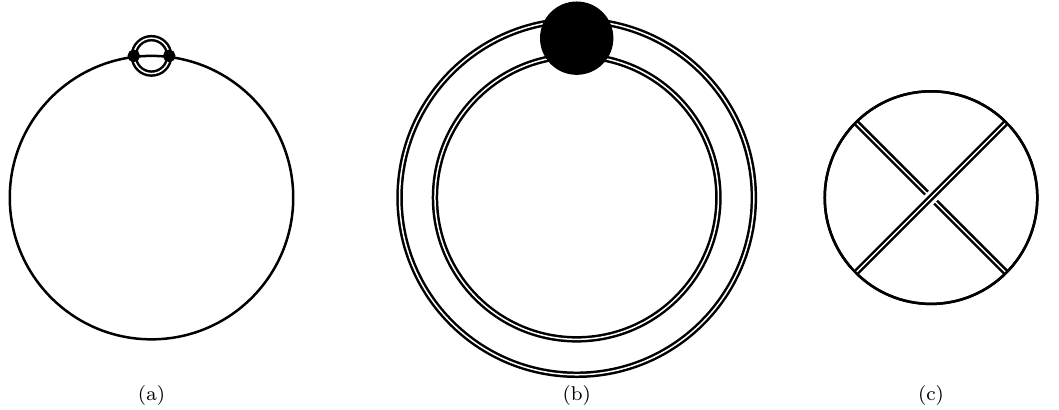
Figure 21 . (a) The big circle is a cartoon representing the locus M dual to w 1 . A (cid:5) line is bubbled nearby and dipped into this locus. The operators at the two marked junctions are inverses of each other. (b) Taking the left half of (cid:5) line around a loop C in M which intersects once the locus L 0 dual to w 2 , brings us to the con(cid:12)guration shown in the (cid:12)gure. We omit M in this (cid:12)gure for brevity. 1 The region denoted by a black disk is shown in (c). That is, the (cid:5) lines are glued inside this black region in such a way that there is a non-trivial half-braiding (i.e. crossing) of the (cid:5) lines. The reason for the appearance of this crossing is that the normal direction to M is re(cid:13)ected across L 0 and hence the top and bottom parts of the (left half of) (cid:5) loop are exchanged as C crosses L 0 . we also need to choose whether we will put m or n on the junctions when (cid:5) crosses R -defect. The Pin + -TFT T is obtained +